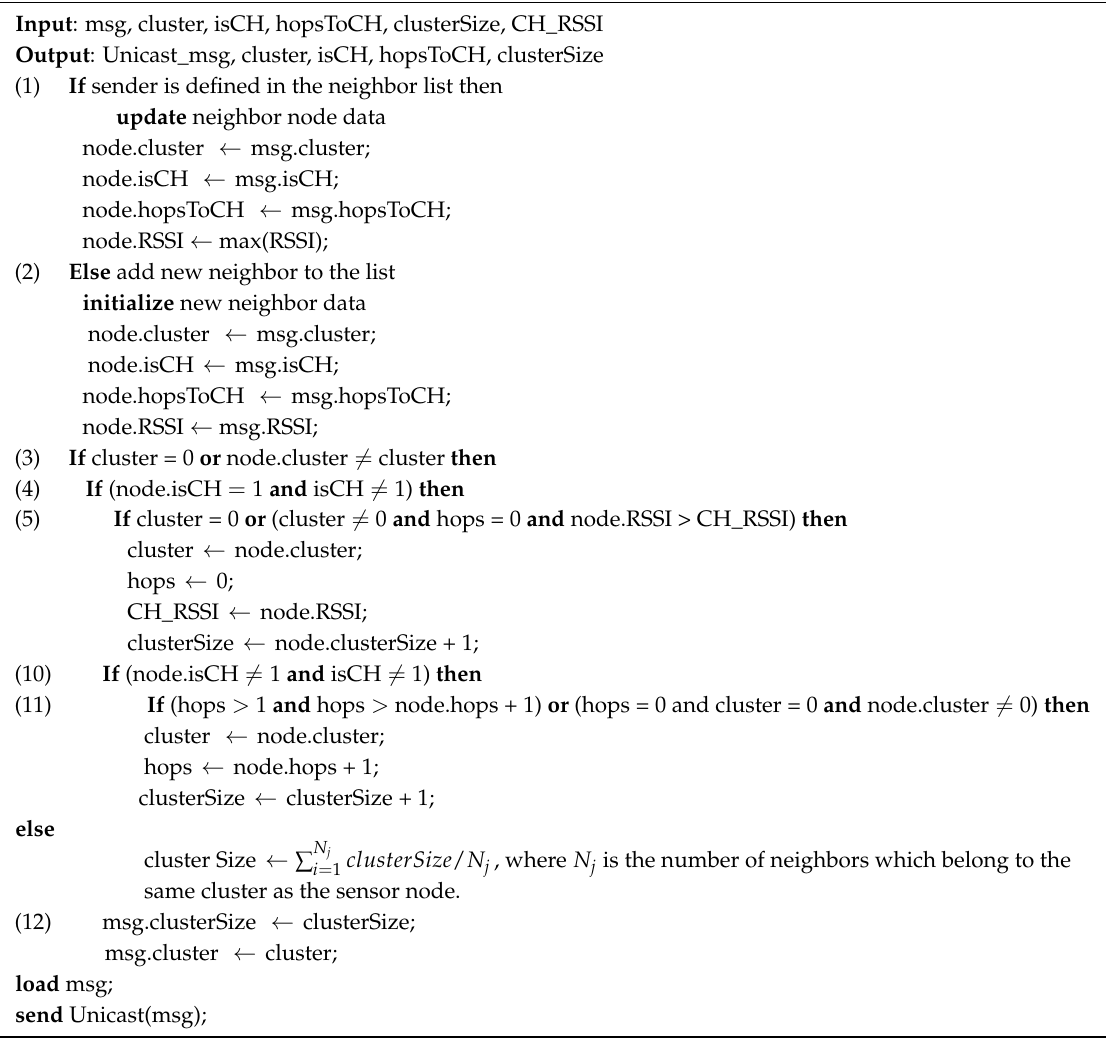
Algorithm 5 . Broadcast message receiving process for clustering phase (pseudo-code).